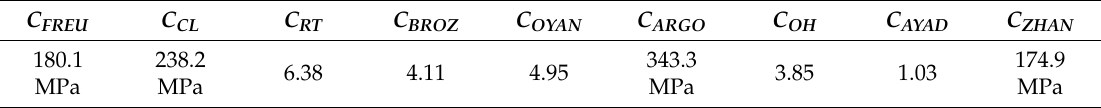
Table 2. Critical damage values for C45 grade steel formed in 1150 ◦ C, determined based on rotational compression in a